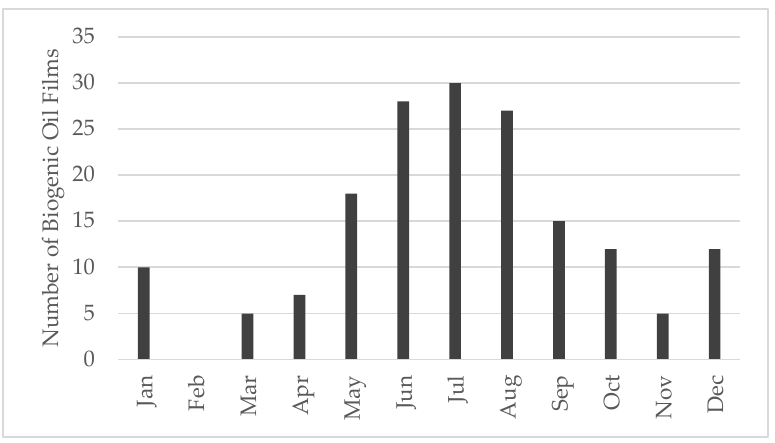
Figure 7. Temporal variation of the biogenic oil films detected.